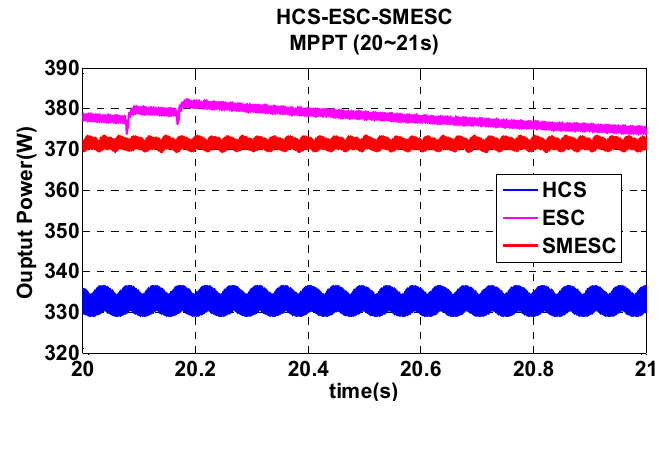
Figure 18. Output dynamic response of HCS, ESC and SMESC algorithms, respectively (variable wind speed, 10.5–12.5 m/s) (20–21